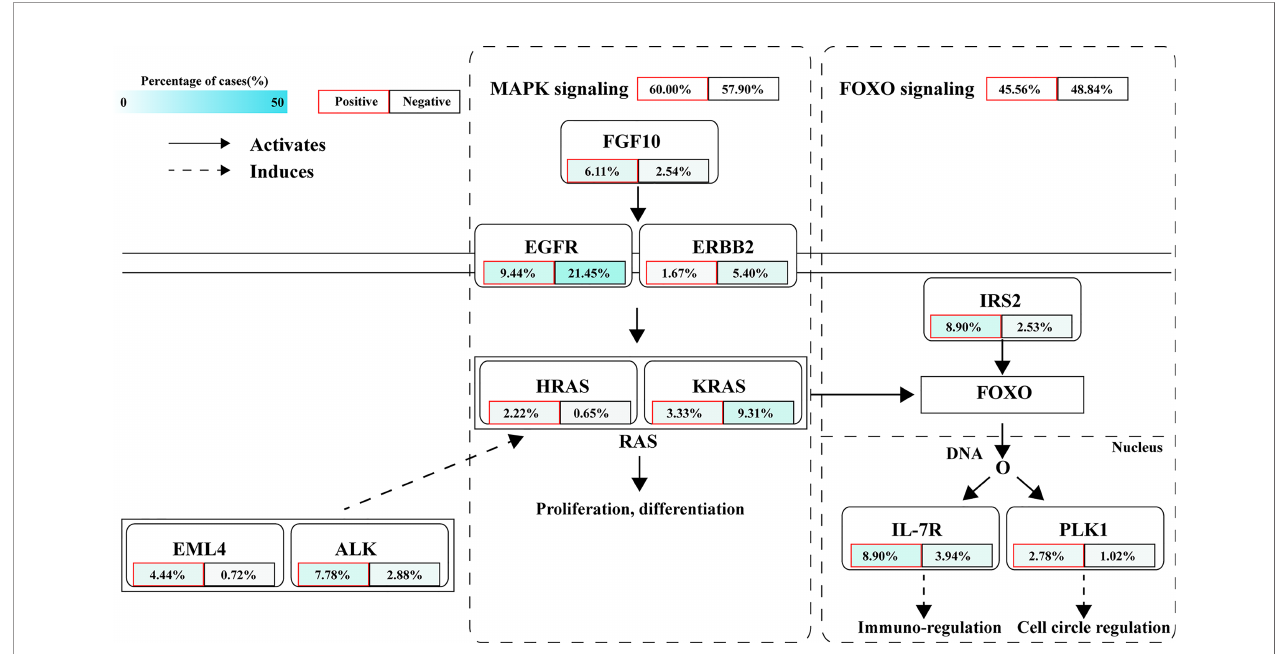
FIGURE 7 | Frequently deregulated signaling pathways in ALK/ROS1/NTRK fusion-positive patients.